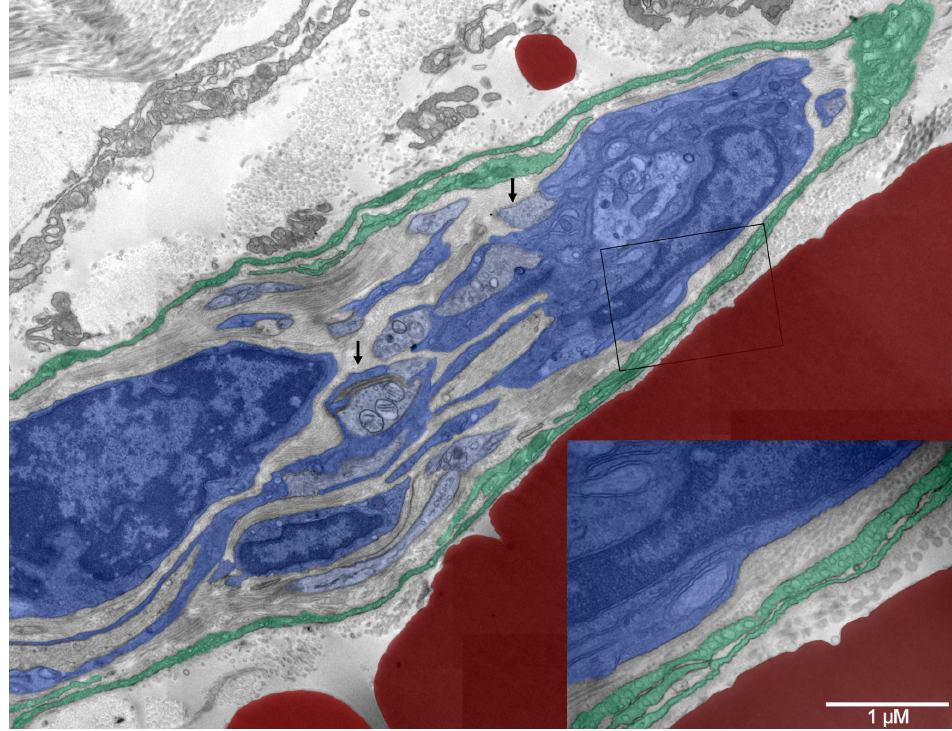
Figure S14. Developing peripheral nerve. Several nerve fibers (light blue) were engulfed by Schwann cells (dark blue) on the right but progressing myelination could be recognized only on the one in the center with three mitochondria in the section plane (left arrow). Multiple nerve boutons with synaptic vesicles (right arrow) were present but mature synapses were absent. Surrounding the nerve fibers was one to three-layer neurothelium (emerald green) with abundant caveolae (insert in the right lower corner). Collagen fibers located internally were thinner (20–40 nm) than those lining the external surface of the neurothelium (60–100 nm). A giant erythroschizosome (red) was located next to the forming nerve and it had similar dimensions (right lower corner behind the